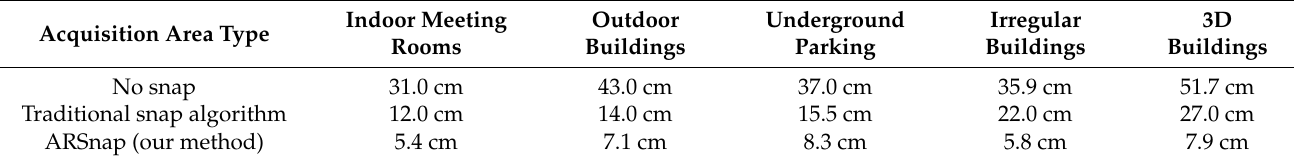
Table 3. Accuracy comparison of the three snap types.